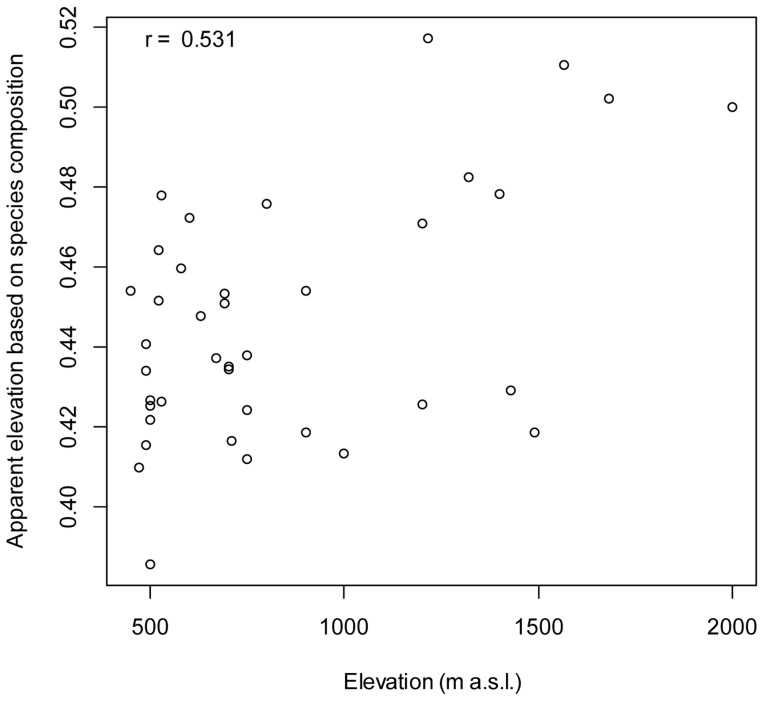
Plot of ordination analysis (Fuzzy Set Ordination; FSO) based on binary data, (presence/absence of species) and mean elevation in each quadrat.Sørensen indices were evaluated with rank and linear correlations with the apparent elevation gradient.